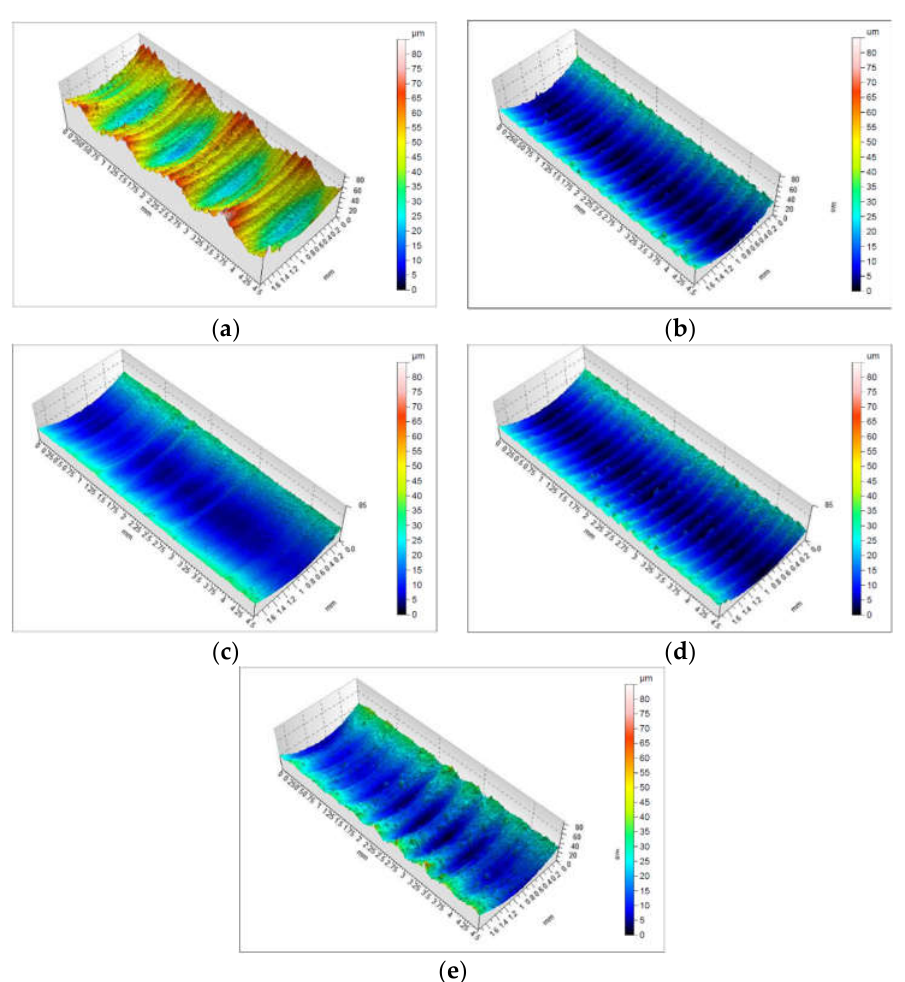
Figure 15. Topography profiles with different vibration amplitudes: ( a ) A = 0 mm, ( b ) A = 0.1 mm, ( c ) A = 0.05 mm, ( d ) A = 0.025 mm and ( e ) A = 0.01 mm with the same frequency f = 4 Hz (see Table 2 tests 23, 19, 20, 21 and 22, respectively). Table 5. Summary of roughness results at different vibration amplitudes with f = 4 Hz.